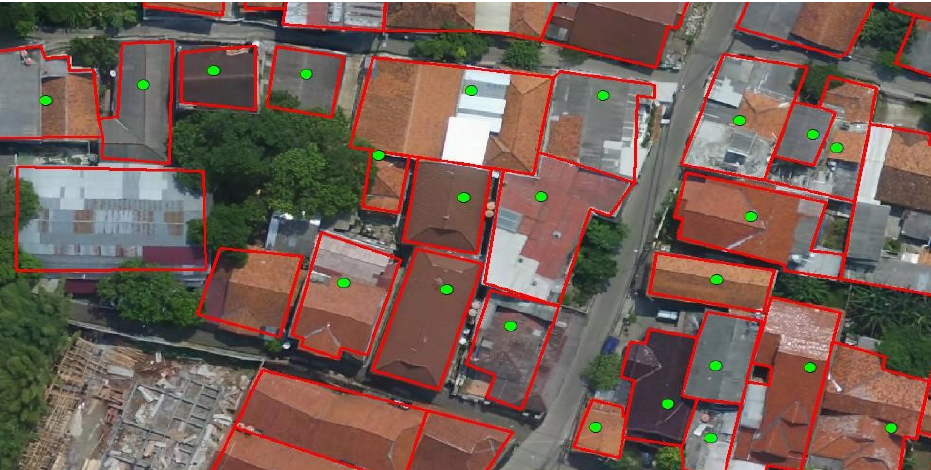
Figure 5. Use of high-resolution aerial photography to help interpret building boundaries (source: data processing documentation).